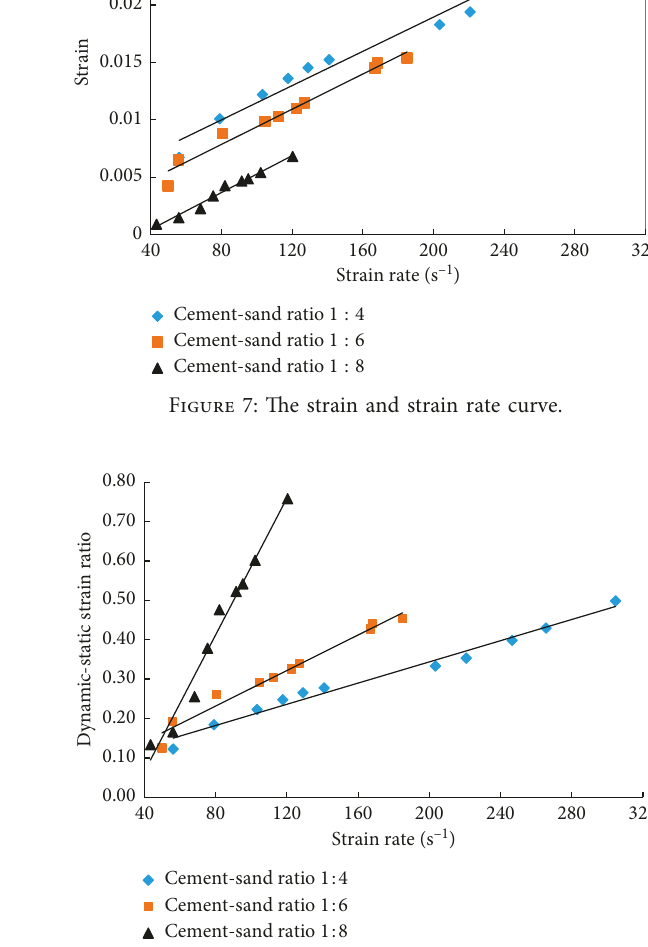
Figure 8: The dynamic and static strain ratio and strain rate curve.